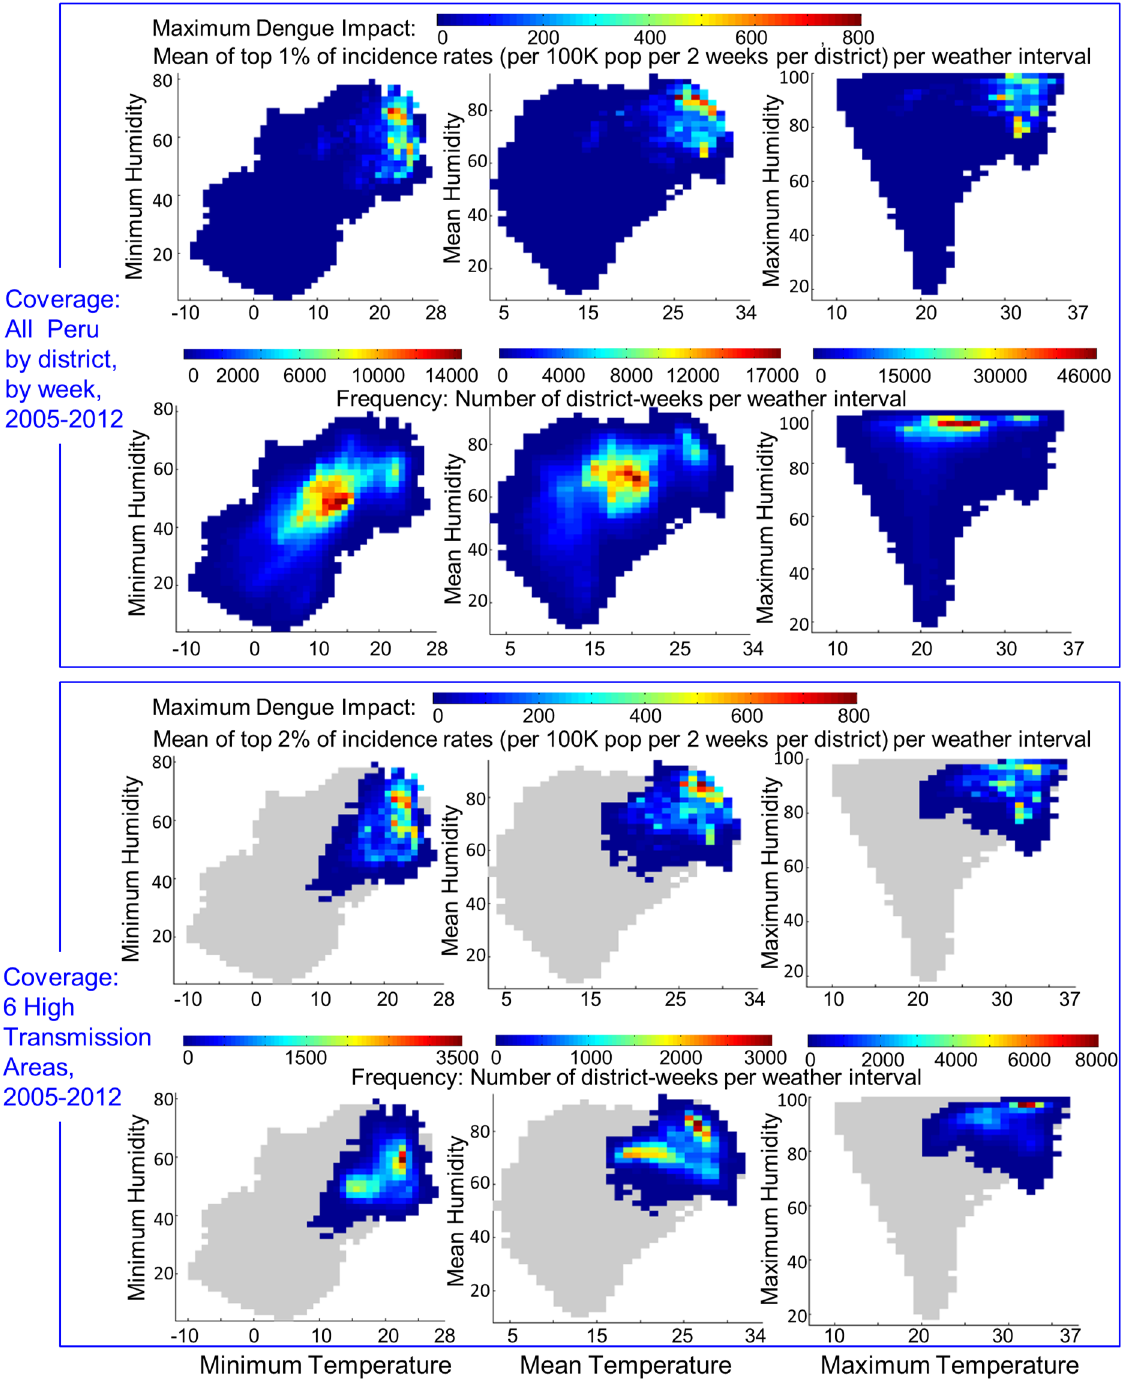
Fig 4. Profile of maximum dengue impact across Peru ’ s temperature-humidity weather-space. Upper panel represents all of Peru. Top row: Maximum dengue impact observed per weather interval is shown for all district-weeks across Peru, 2005 – 2015. Second row: The frequency distribution of weather intervals (where time is spent per week) annually is shown for all districts across Peru. Lower panel represents the 6 highest dengue incidence regions of Peru (Tumbes, Piura, Maynas, Alto Amazonas, Ucayali, Madre de Dios). Third row: Maximum dengue impact observed per weather interval is shown for all district-weeks across the 6 areas combined. Bottom row: The frequency distribution of weather intervals (where time is spent per week) annually is shown for all districts across the 6 highest dengue incidence locations. The shaded grey area indicates the weather-space for all of Peru. Grid interval is 1°C temperature and 2%